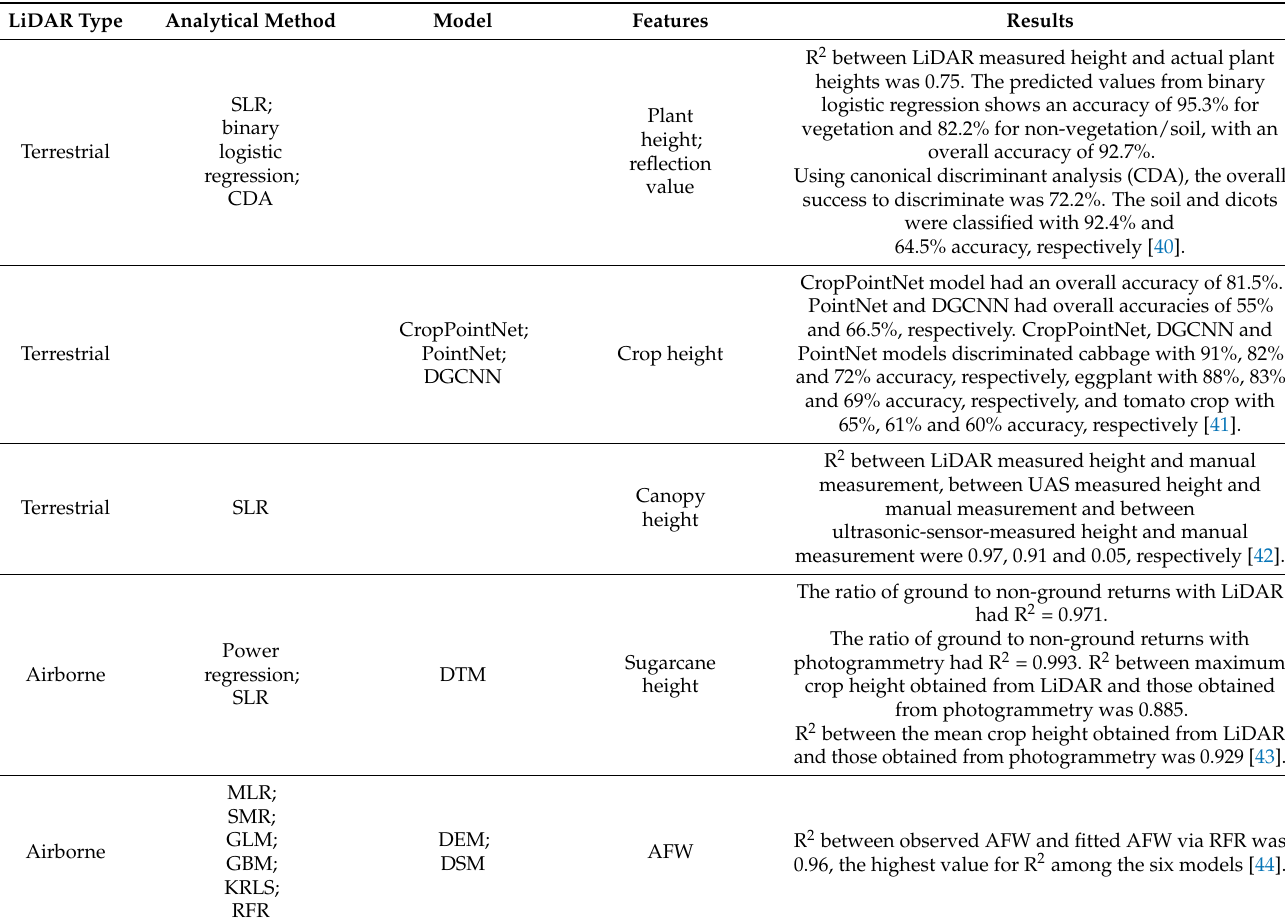
Table 5. Comparison of LiDAR data in weed, crop and soil detection and crop growth